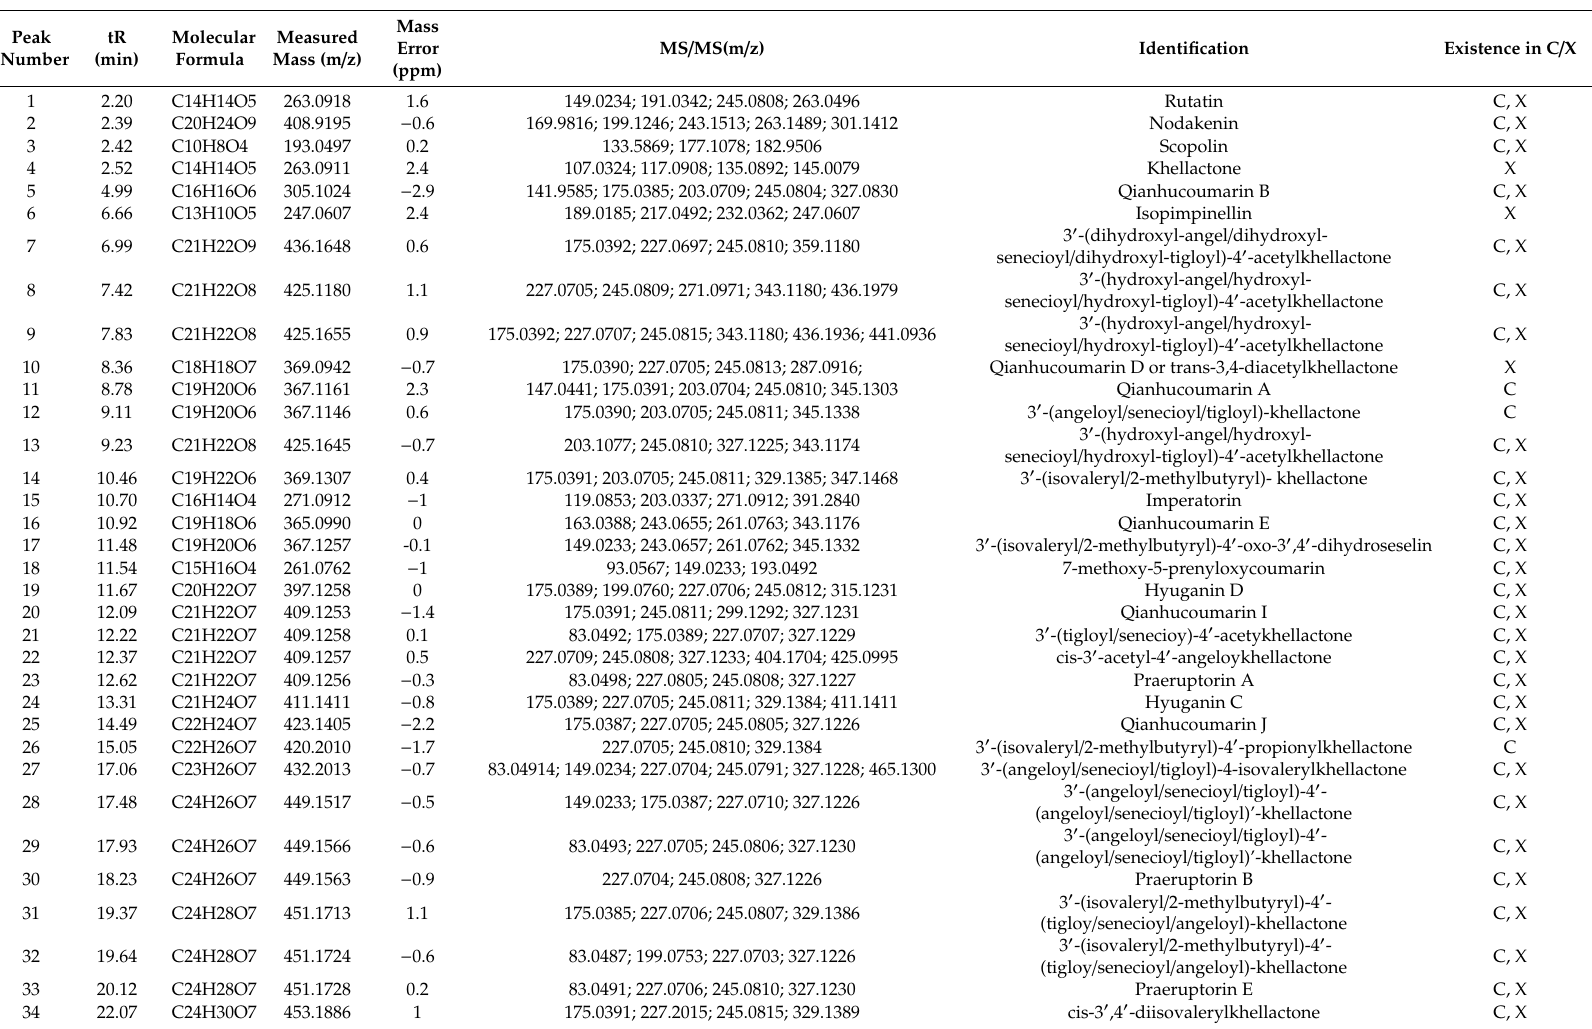
Table 1. Chemical characterization of cross-section extractions by